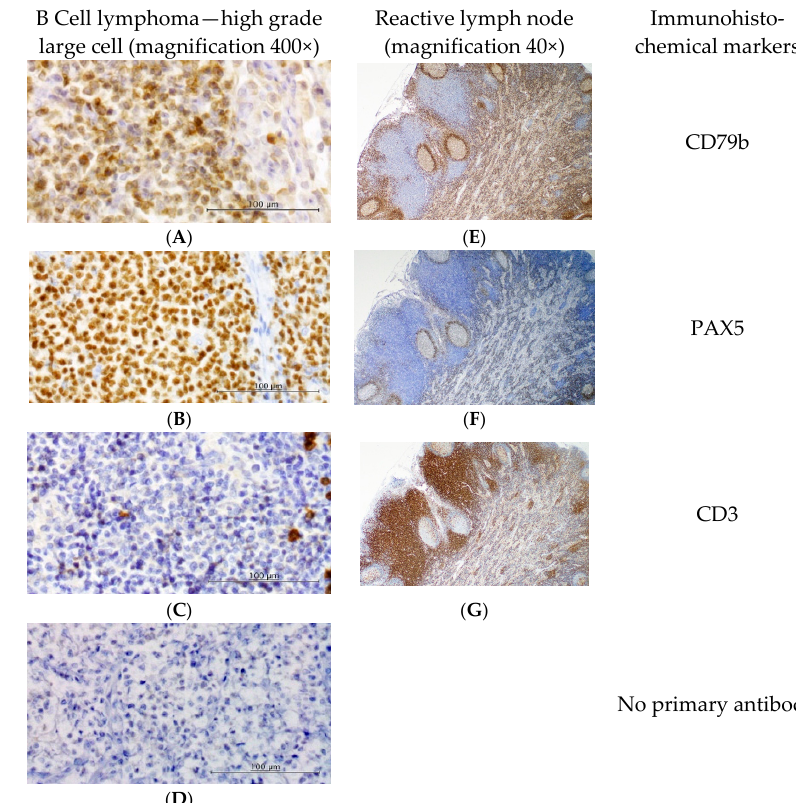
Figure 2. Immunohistochemical labelling. Results from a representative B cell lymphoma